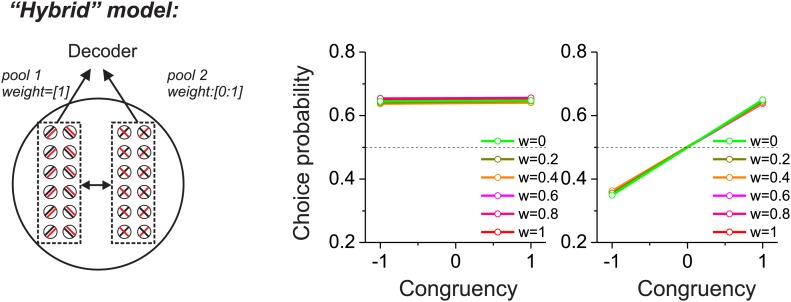
Predictions from a “hybrid” model (see text for details) in which correlated noise was assigned according to vestibular signal correlations, and heading was decoded relative to the vestibular heading tuning of each neuron.CP patterns were roughly similar to those seen in the pure-correlation model (Figure 2C,D).